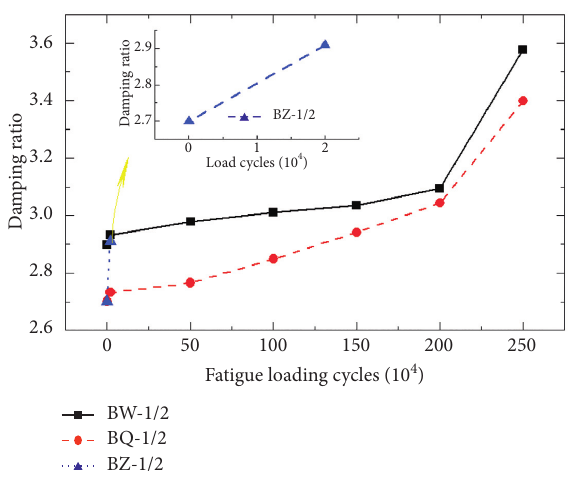
Figure 19: Damping ratio of test plate under fatigue loading.